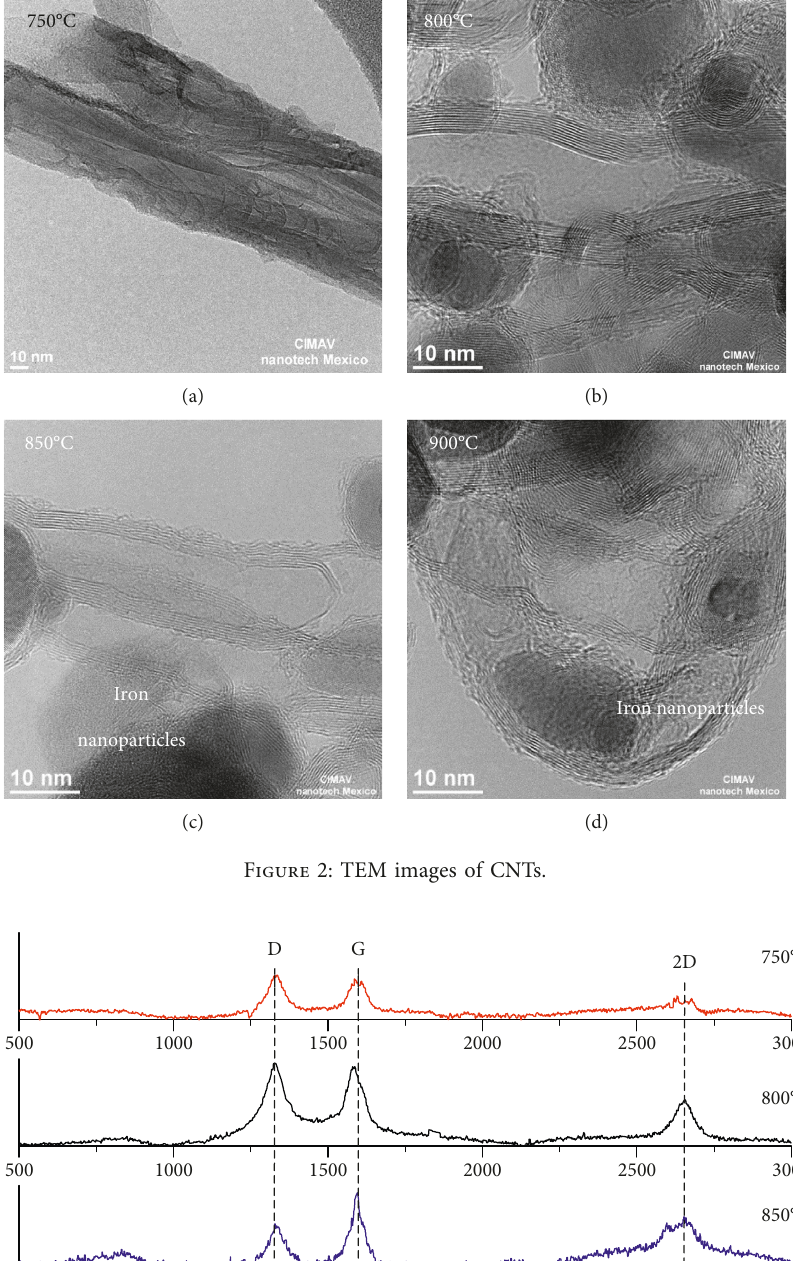
Figure 3: Raman spectra of